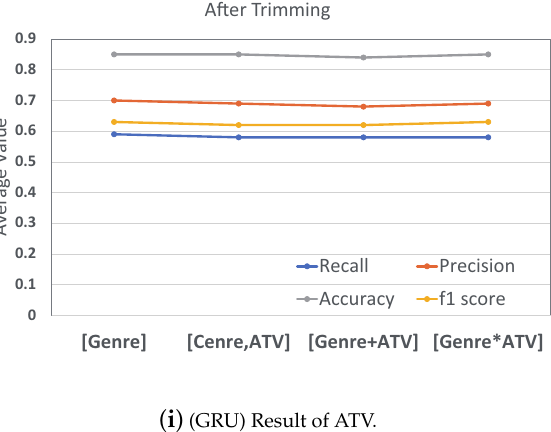
( g ) (GRU) Result of ATV. ( h ) (GRU) Result of ATV.